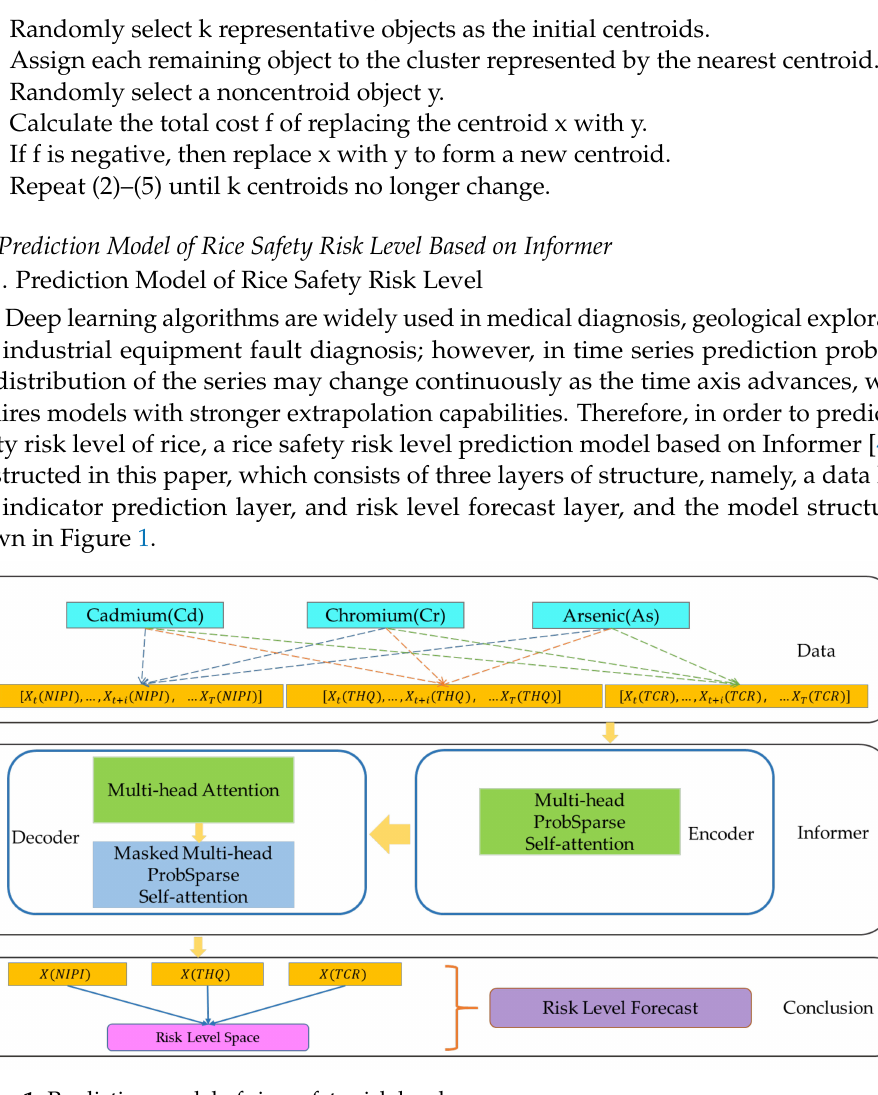
Figure 1. Prediction model of rice safety risk